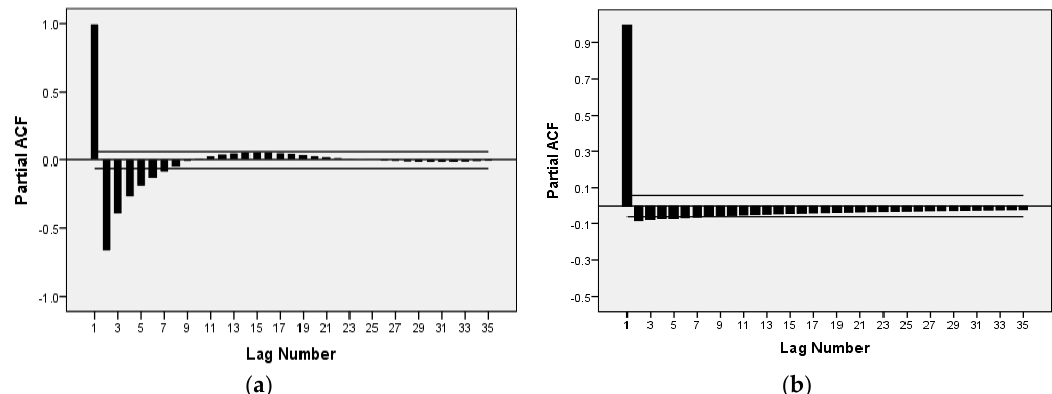
Table 5. The parameters of each subsequence after processing by EMD-SE.